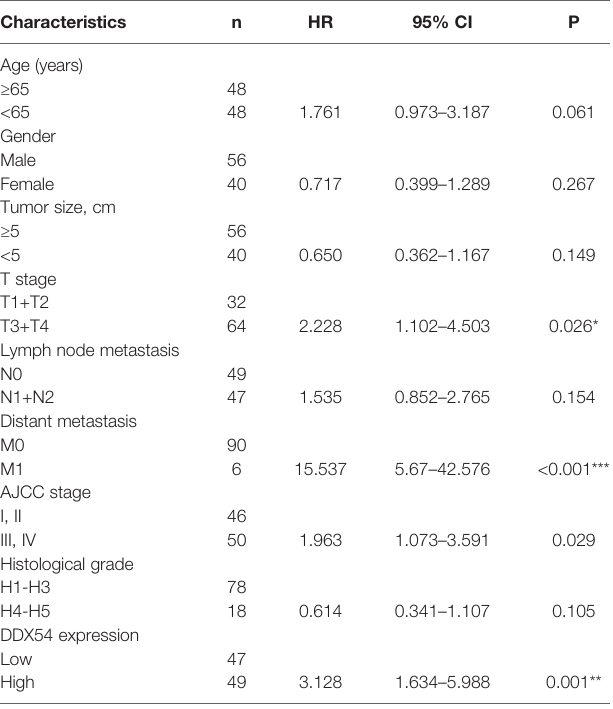
TABLE 3 | Multivariate Cox regression analysis of potential prognostic factors for colorectal cancer patients.